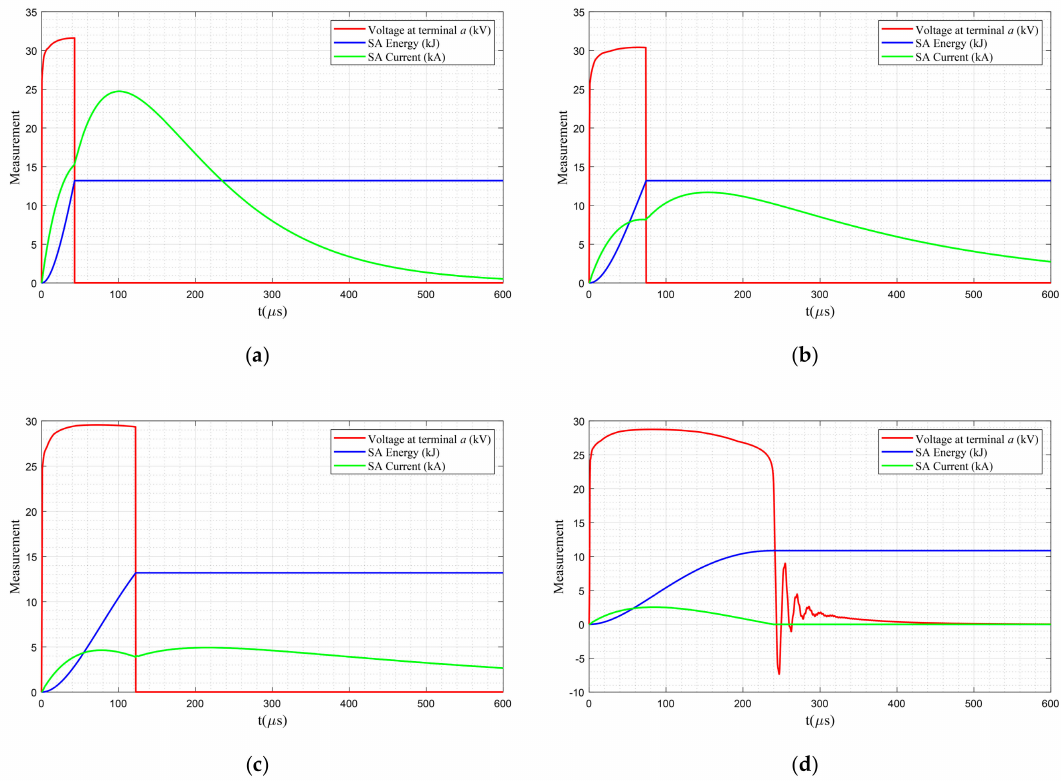
Figure 24. Performance of filtered surge arrester SA-12a under the 100 kV lightning impulse with